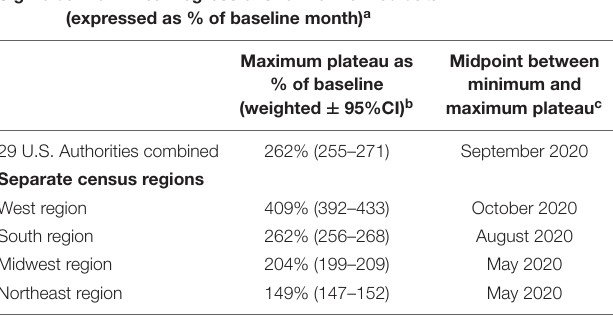
TABLE 2 | Non-linear sigmoidal regressions for overdose mortality caused by synthetic